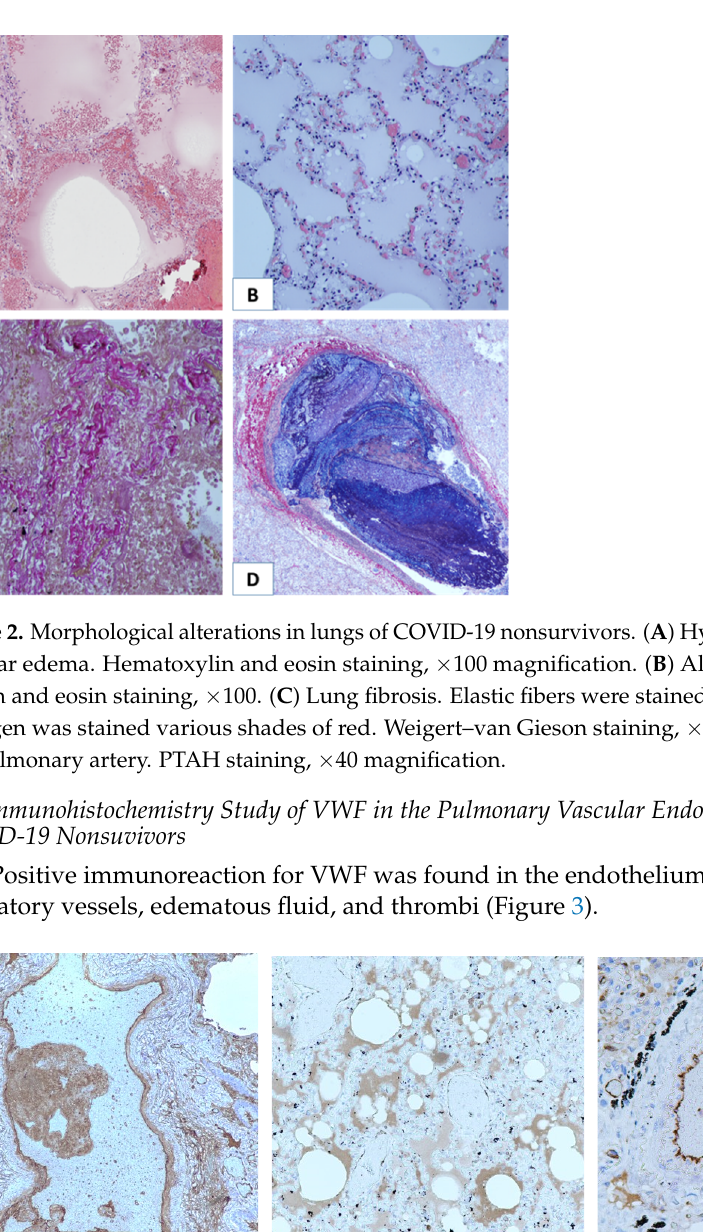
Table 1. Frequency and structure of thrombotic complications in COVID-19 nonsurvivors in relation to disease duration.